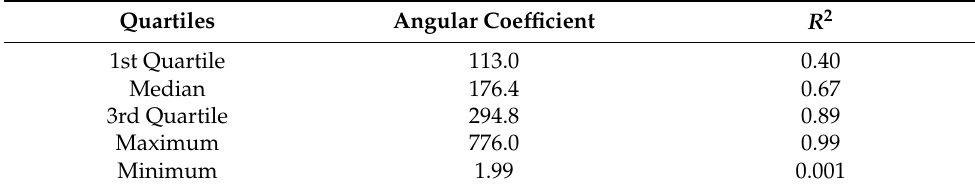
Table 3. Quartile distribution of angular coefficients and R 2